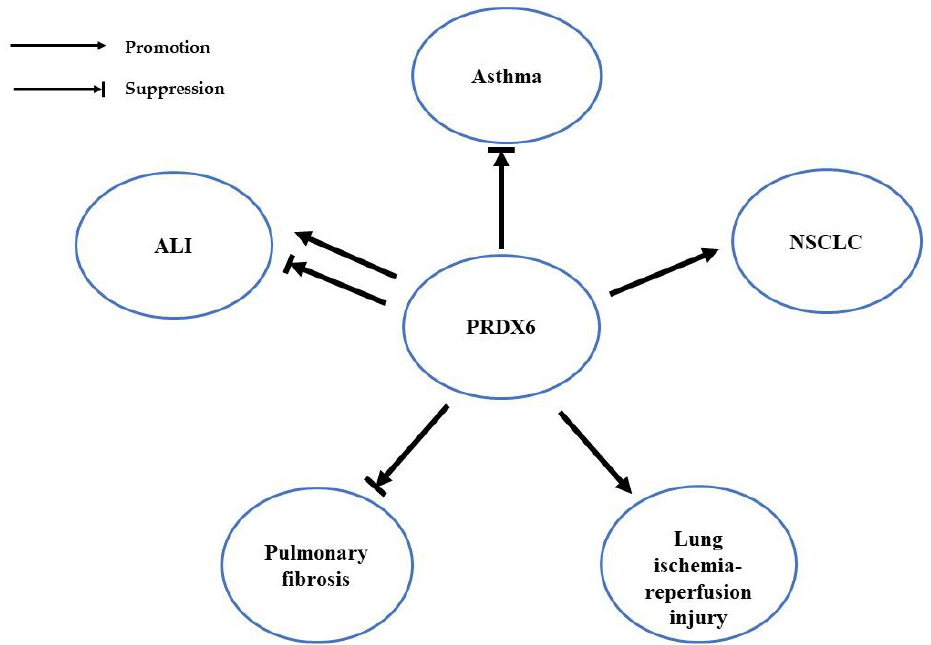
Figure 3. Role of PRDX6 in different respiratory diseases.